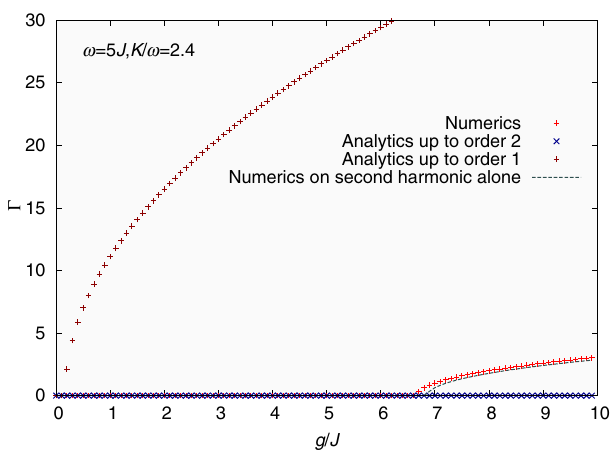
FIG. 20. Comparison between the numerically and analytically computed instability rate Γ in the case K= ω ¼ 2 . 4 [zone C on the stability diagram of Fig. 2, where J 0 ð K= ω Þ ≈ 0 and J 2 ð K= ω Þ is large]. Since the effective Bogoliubov dispersion is flat, the analytical perturbative approach breaks